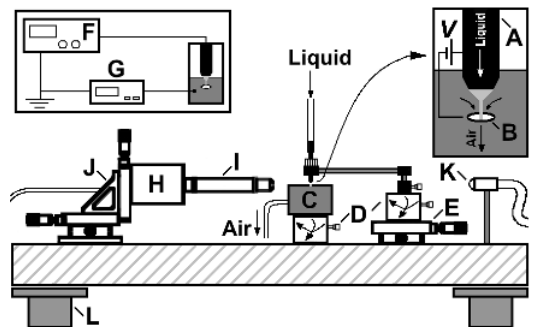
Fig. 2. Experimental setup: (A) needle / capillary, (B) plate with orifice, (C) suction cell, (D) orientation systems, (E) translation stage, (F) high volatge power supply, (G) picoamperimeter, (H) camera, (I) optical lenses, (J) triaxial translation stage, (K) op- tical fiber connected to a stroboscope light source, and (L) anti- vibration isolation system.